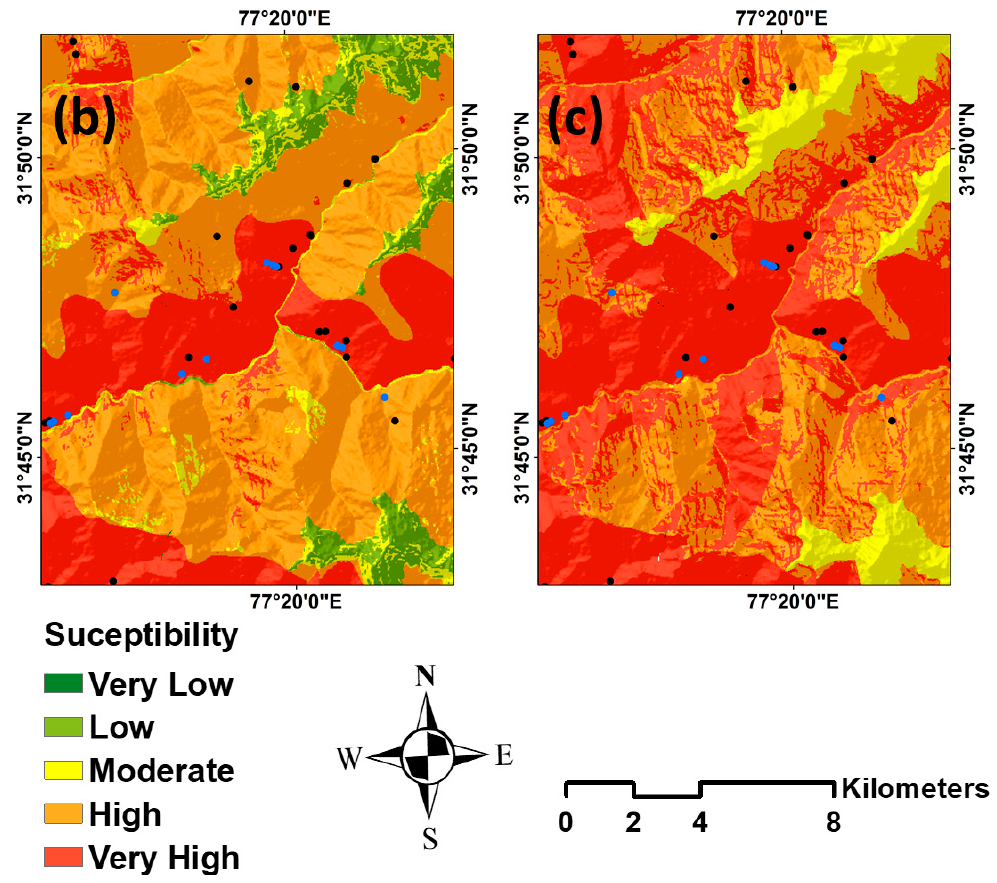
Figure 5. An enlarged sub-area from the resulting LSMs generated based on three different models ( a ) AHP, ( b ) FR, and ( c ) hybrid